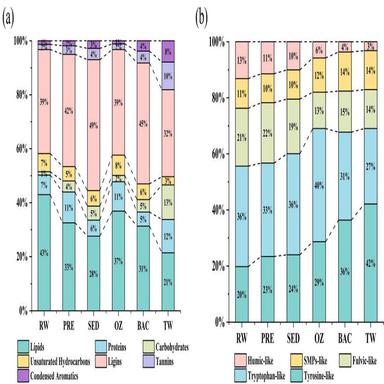
DOM composition in water samples from the waterworks using (a) FT-ICR MS; (b) EEM. Bar chart illustrates the proportion of major compound classes.